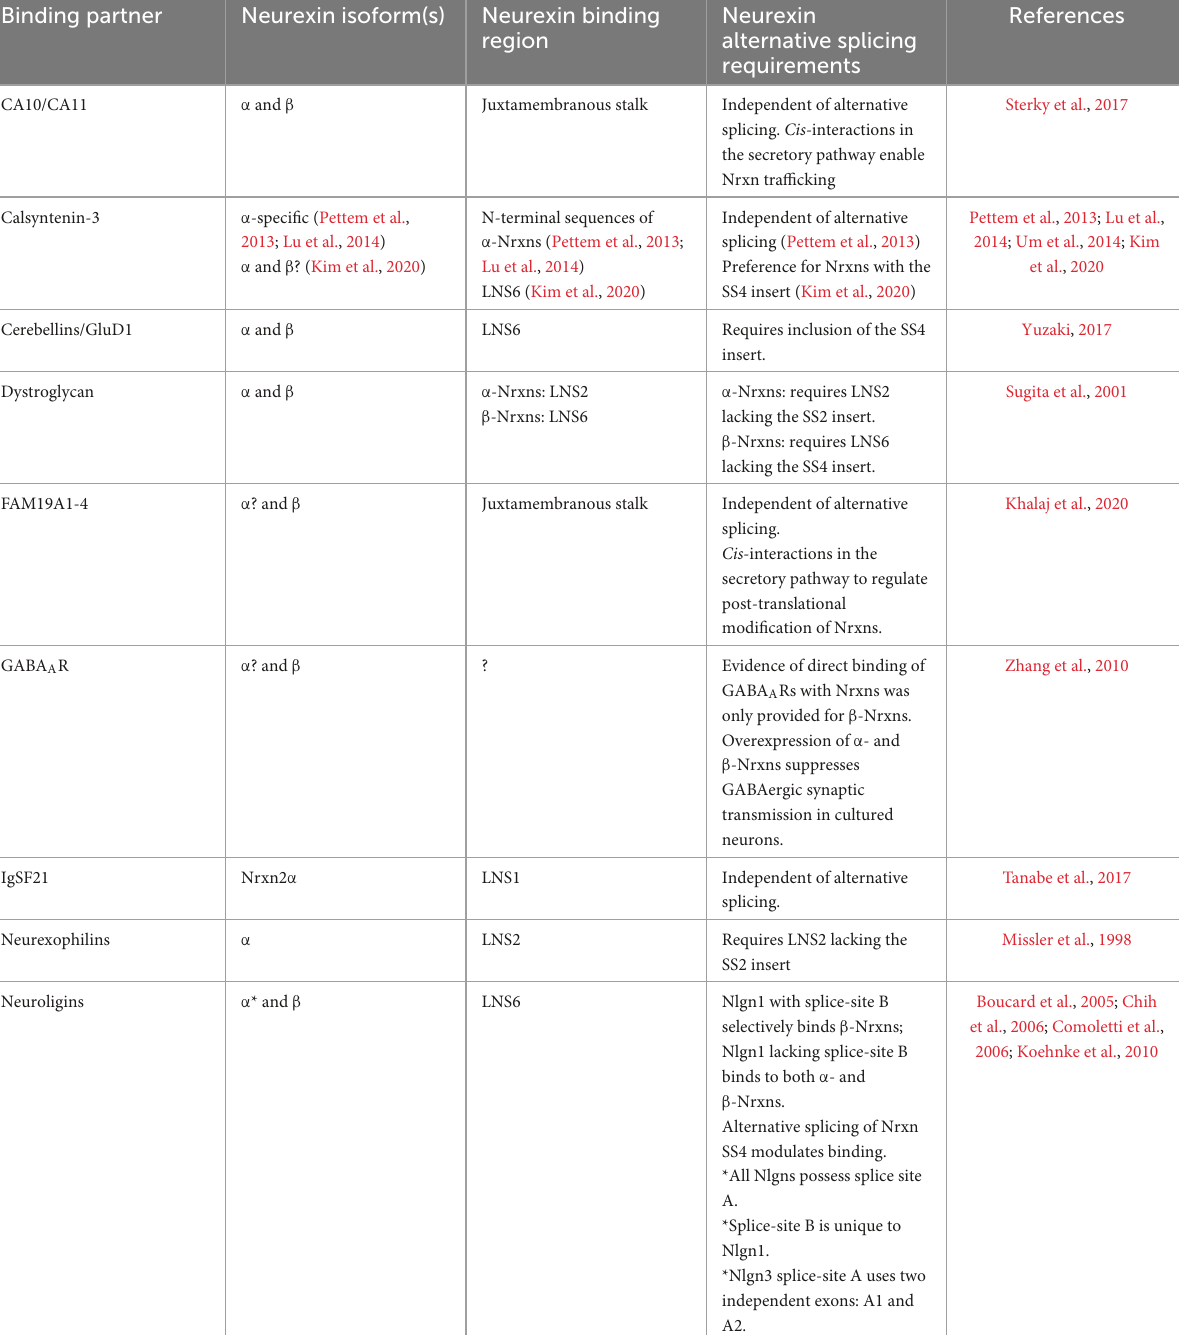
TABLE 2 Binding requirements of Nrxns with ligands found at inhibitory